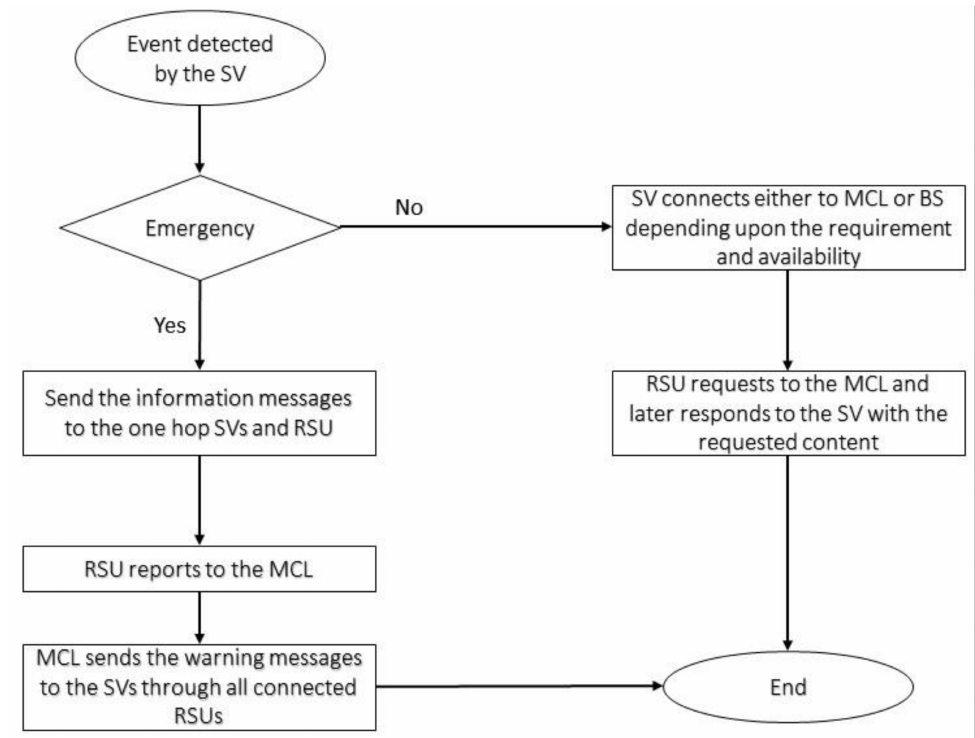
Figure 5. The interaction flowchart of the sensing layer, reporting layer, and processing